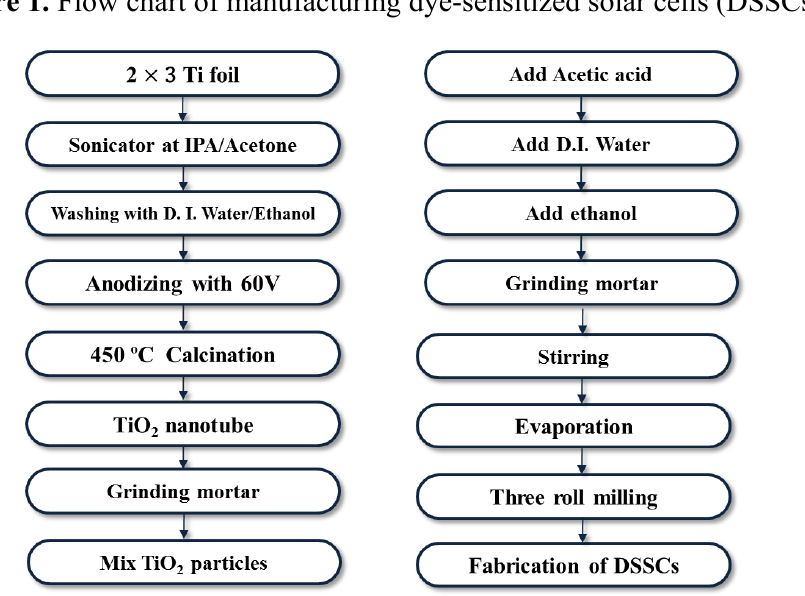
Figure 1. Flow chart of manufacturing dye-sensitized solar cells